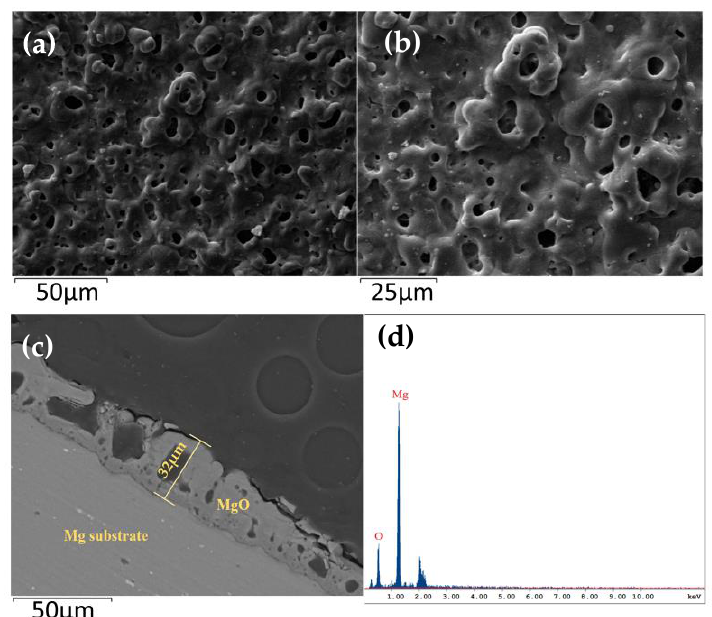
Figure 3. SEM images of micro-arc MgO film layer surface ( a ) low magnification and ( b ) high magnification; ( c ) section image of micro-arc MgO; ( d ) EDS image of micro-arc MgO.